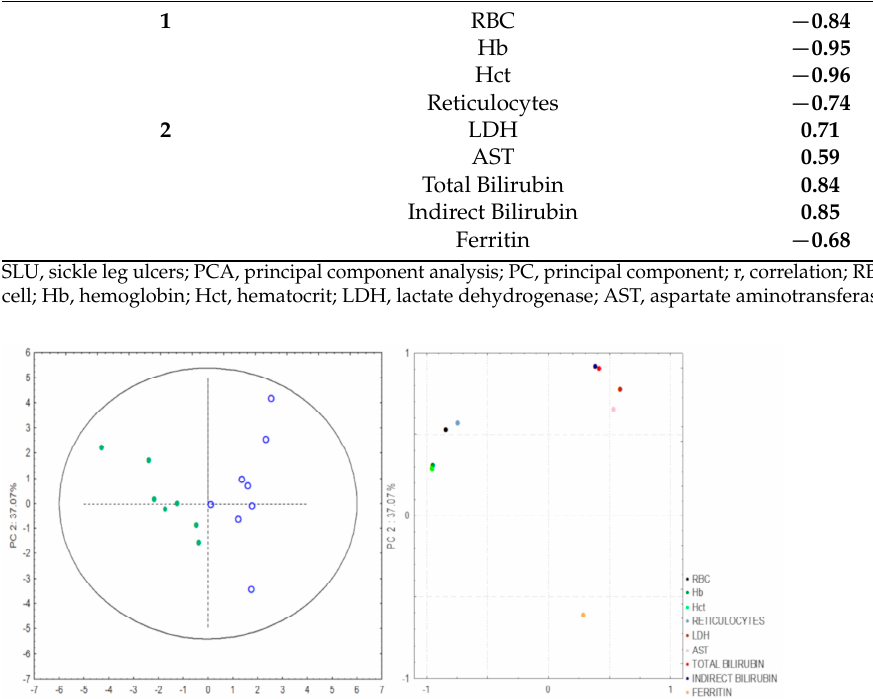
Table 5. Linear regression multivariate model of SLU recurrence in aassociation with laboratory biomarkers.